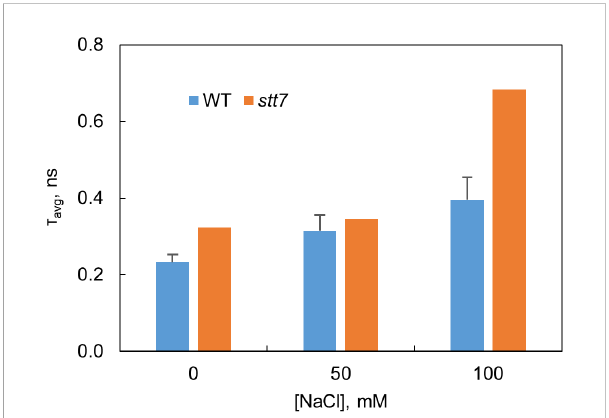
FIGURE 4 Average fl uorescence decay lifetimes at 680 nm determined from the fl uorescence kinetics of C. reinhardtii WT and state transition kinase 7 ( stt7) cells grown in media of different